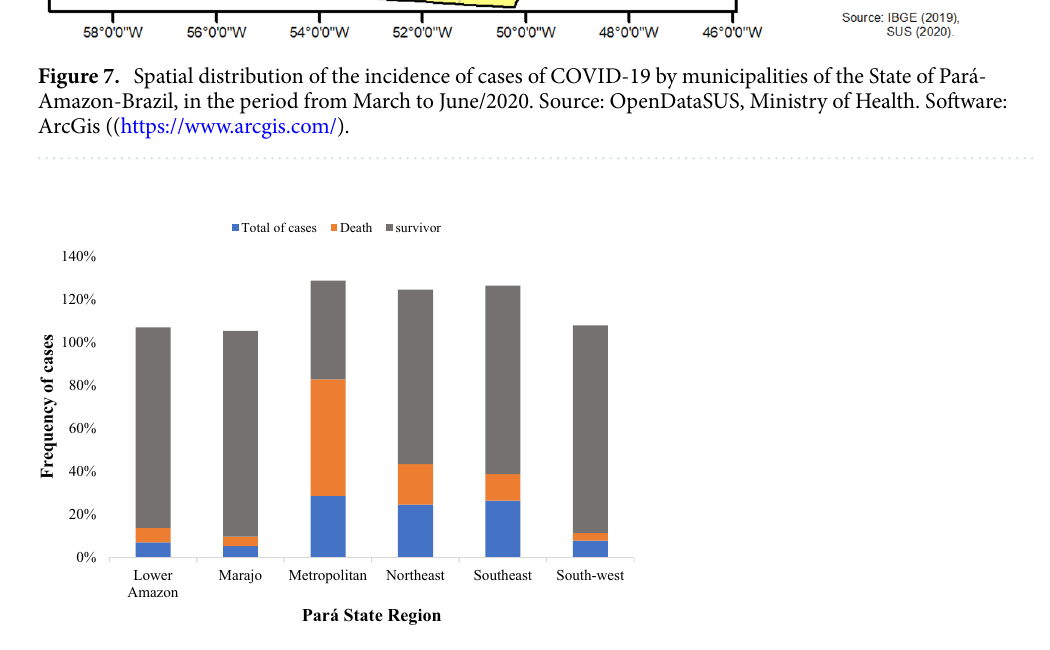
Figure 8. Frequency of cases of SARS-CoV-2 infection distributed by clinical outcomes and regions of the State of Pará-Amazonia-Brazil, 2020. Source: OpenDataSUS, Ministry of